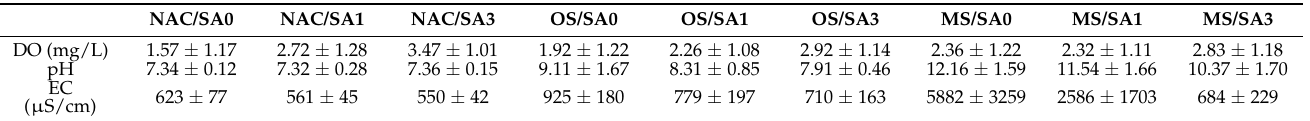
Table 2. Dissolved oxygen (DO) concentration (mg/L), pH, and electric conductivity (EC, µ S/cm) under uncapped and capped